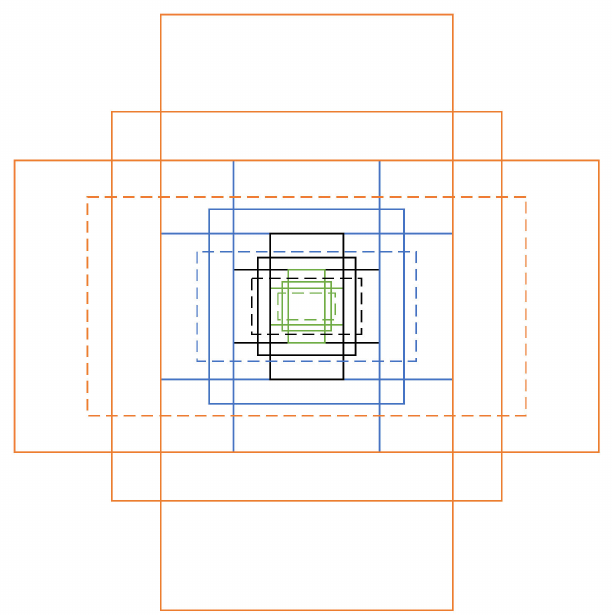
Figure 10. Resultant anchor box after adding 1.5 aspect ratio (dotted line boxes).